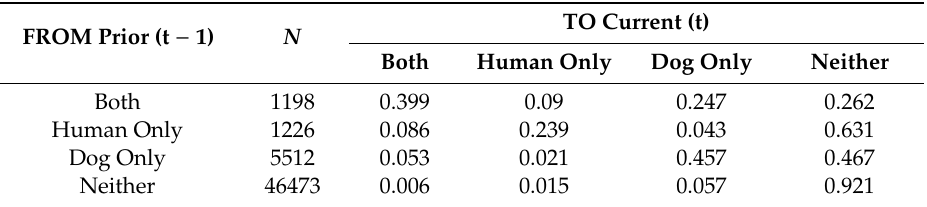
Table 2. Transition probabilities for 2 × 2 state model.